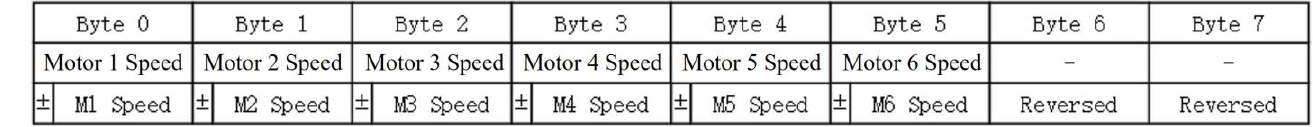
Figure 18. CAN send data format of the host computer.